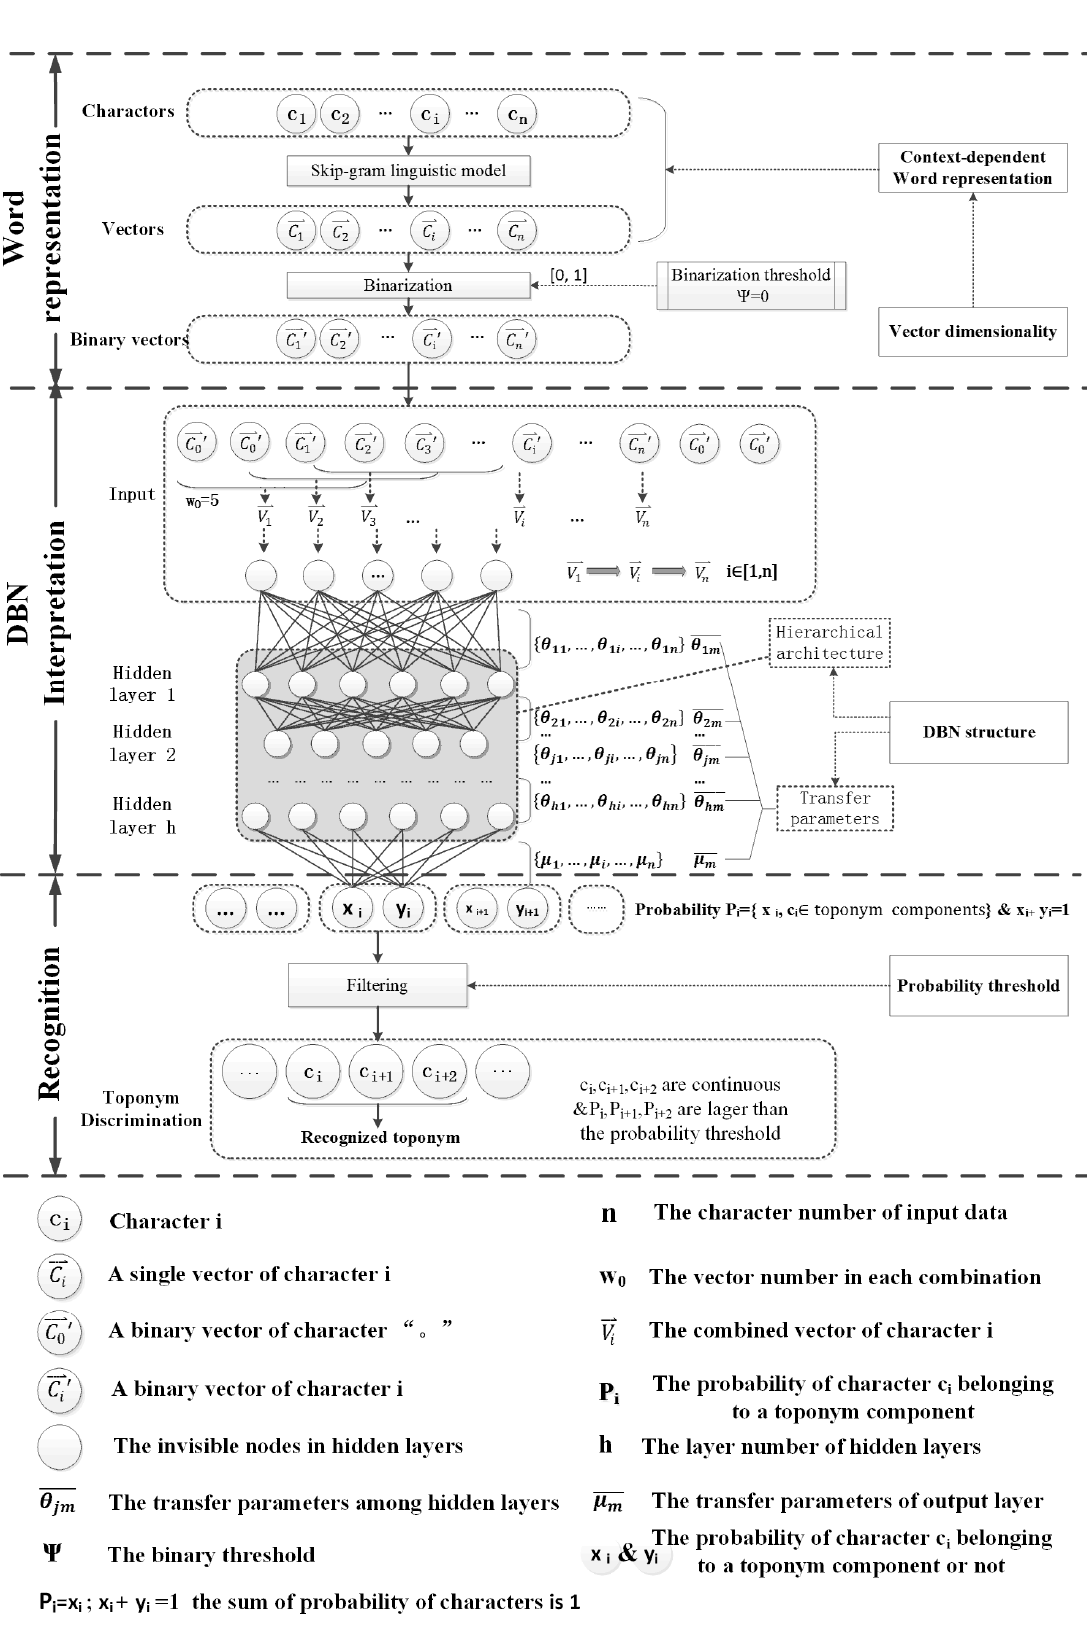
Figure 1. The framework of toponym recognition based on DBN model.